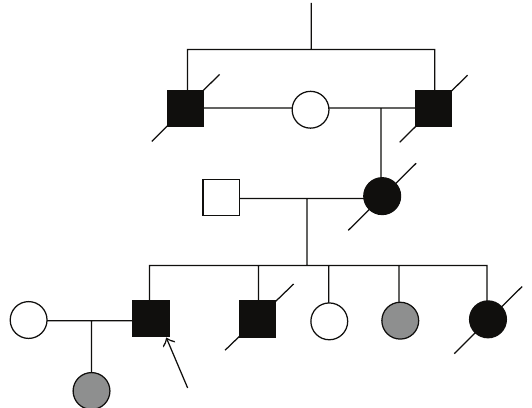
Figure 1: Partial pedigree of the family and mutation segregation. Square and circle symbols represent male and female, respectively. The genotypes of the exon ii polymorphism are shown under the symbols. Arrow: proband. Grey symbols: asymptotic carriers of the mutation.